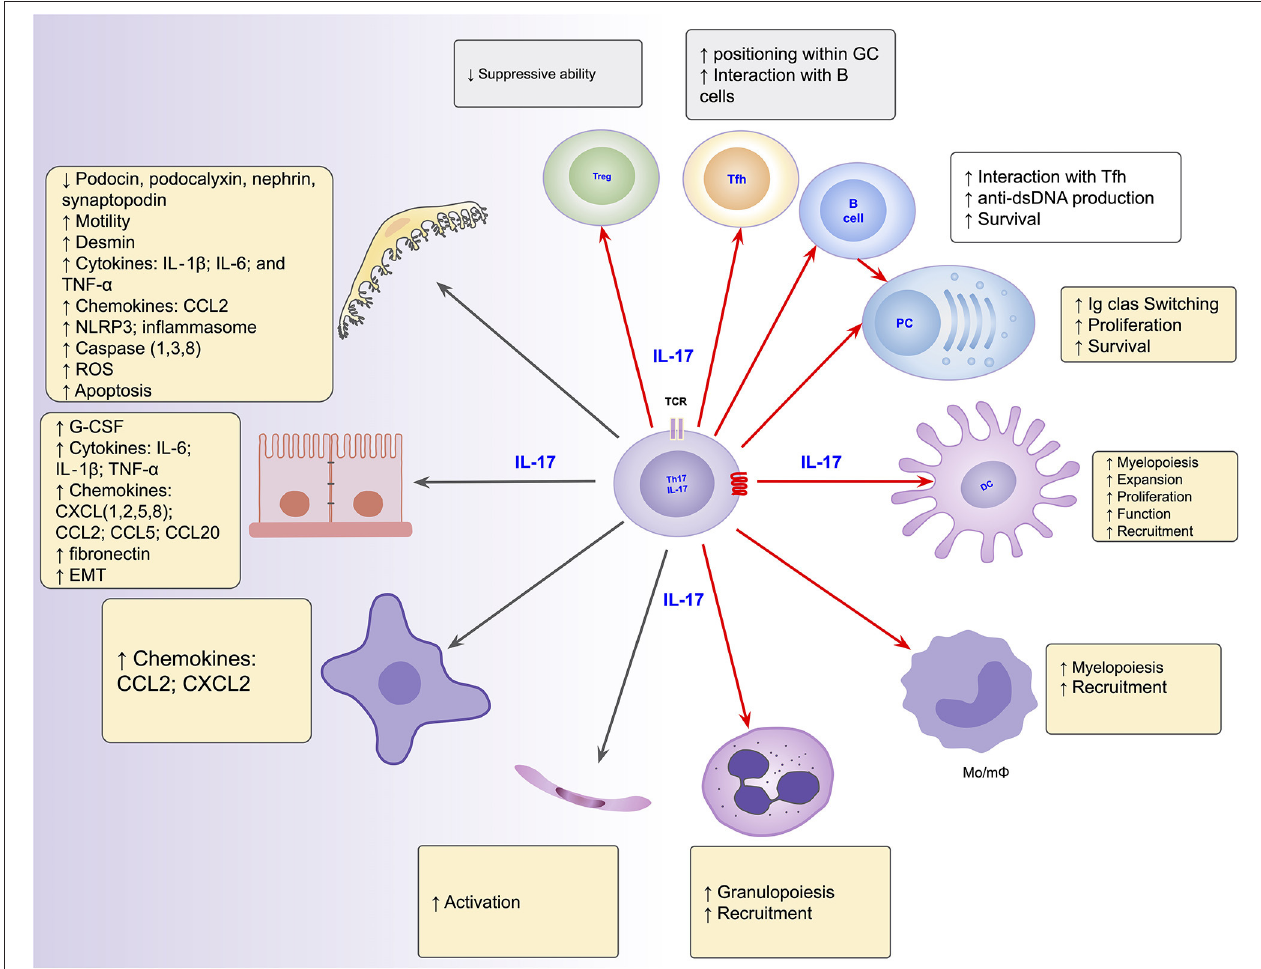
FIGURE 2 | Summarized effects of the Th17/IL-17 axis on intrinsic renal cells (black arrows), as found in several kidney disease models, and on immune cells (red arrows) potentially implicated in the induction of kidney damage in lupus nephritis. DC, dendritic cells; EMT, epithelial-mesenchymal transition; IL-1, Interleukin-1; IL-17, Interleukin-17; IL-6, Interleukin-6; Mo / m Φ , Monocytes/macrophages; PC, Plasma Cells; Tfh, follicular helper T cells; Th17, T helper lymphocytes, subtype 17; Treg, Regulatory T